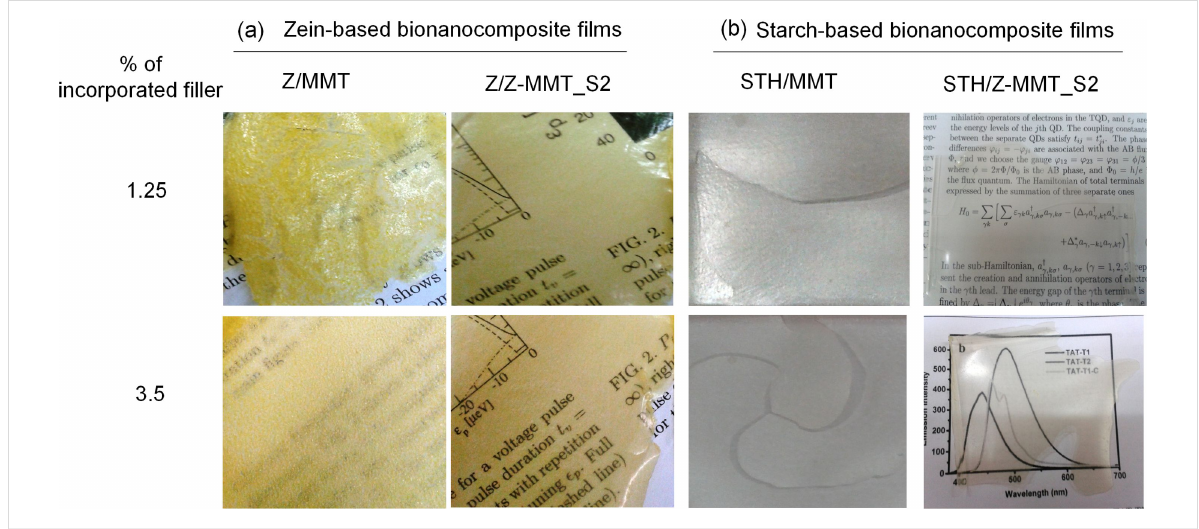
Figure 7: Photographs of (a) zein and (b) starch bionanocomposite films loaded with pure MMT or Z-MMT_S2-46 biohybrid.